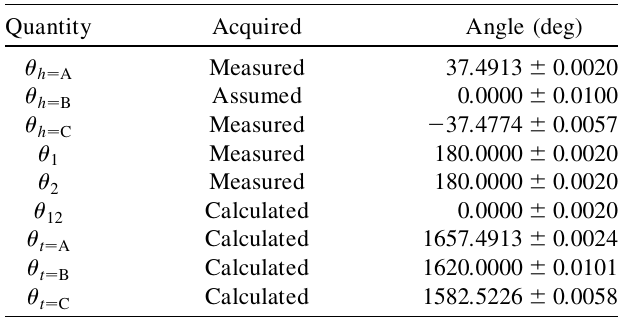
TABLE VIII. The gyrotheodolite survey measurements are shown along with the resulting calculated parameters needed for the spin precession results. The angle of the beam line to Hall B was not surveyed with the gyrotheodolite and is included as an assumed